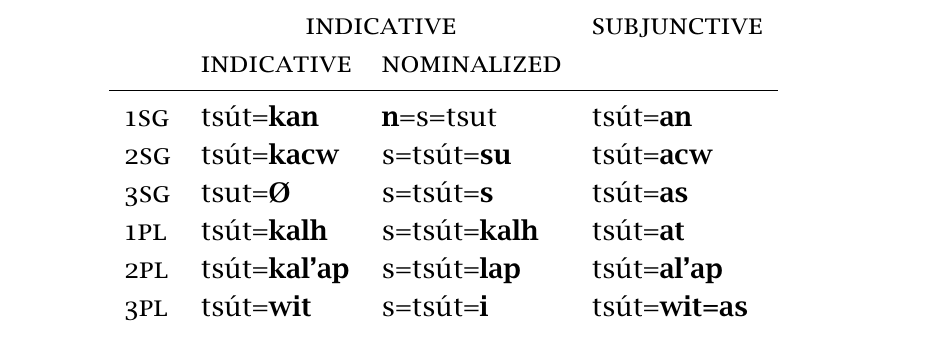
Subject agreement paradigms for the intransitive predicate